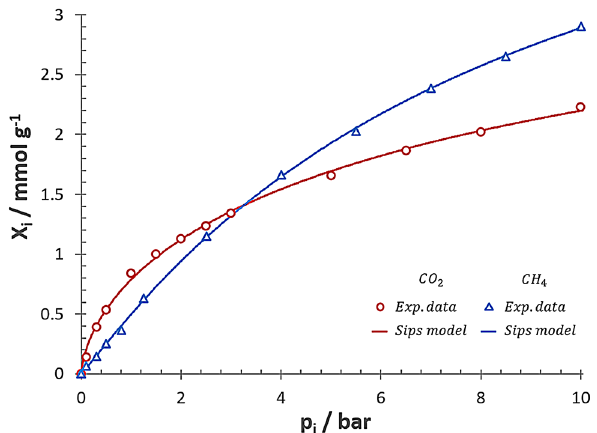
Fig. 10 Adsorption equilibria of Ni-MOF-74@Al and CH (blue) at T = 303.15 K approximated by the Sips isotherm 4